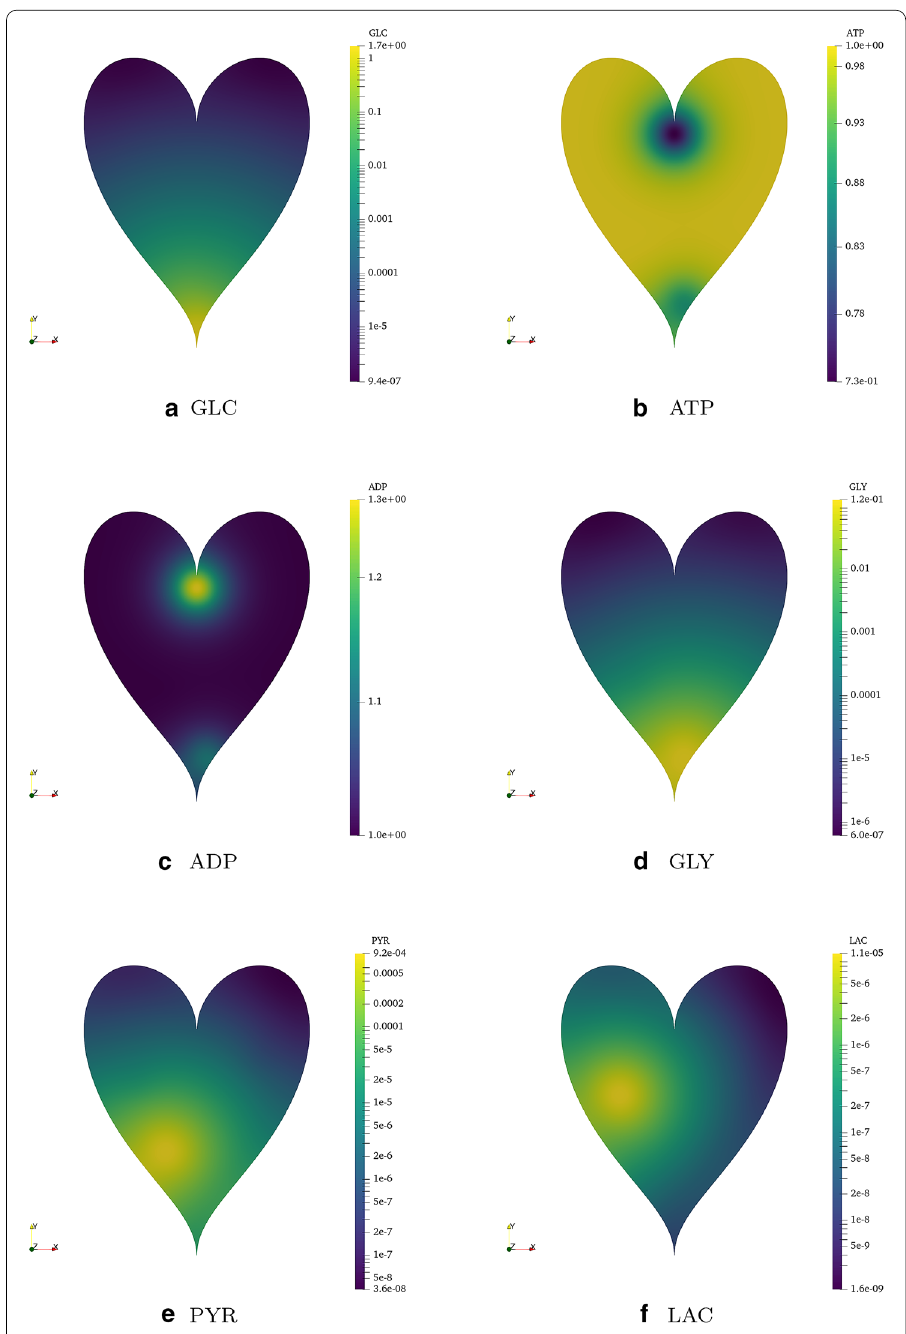
Fig. 10 Solutions of the Model obtained in a heart-shaped domain at the Initial time ( t = 0). GLC is entering the domain from the infimum of the domain. ATP is used in the region where act and HXK are located, vice versa ADP is produced. GLY is produced from HXK. We can see PYR and LAC produced by PYRK and LDH,